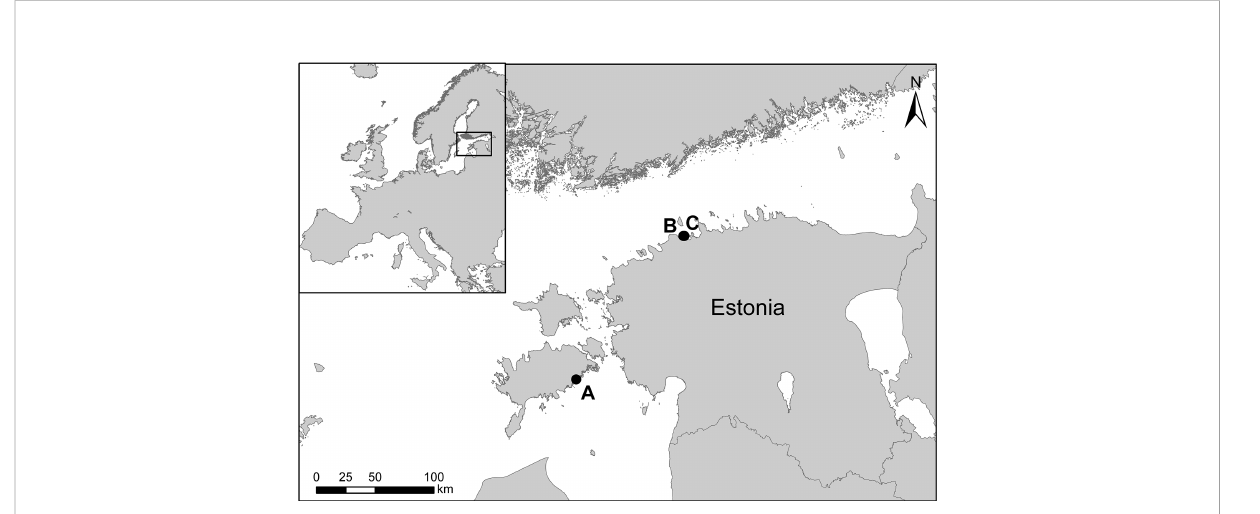
FIGURE 1 Map of the Estonian coastline. Sampled specimens were retrieved from (A) Kõiguste Bay, (B) Kukumäe Bay, and (C) Tallinn